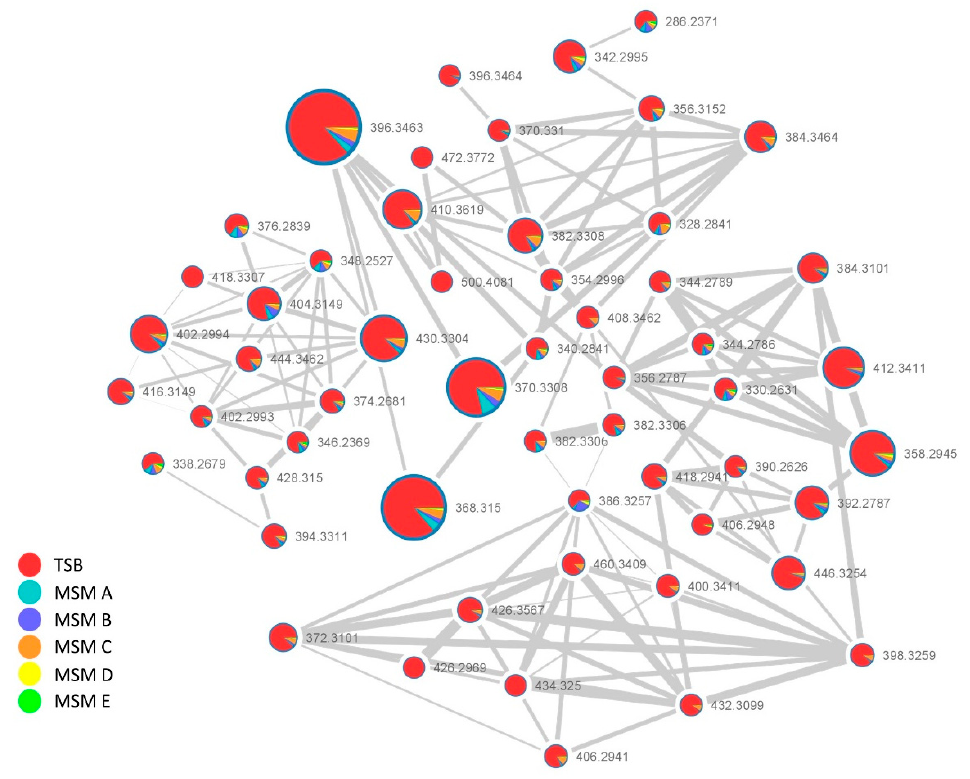
Figure 6. Lipoamino acids cluster in P. cf. eucrina D2, the size of the nodes is directly proportional to the precursor ion intensity, while the color (explained in the color chart) is dependent on the growth media in which the ion was detected.